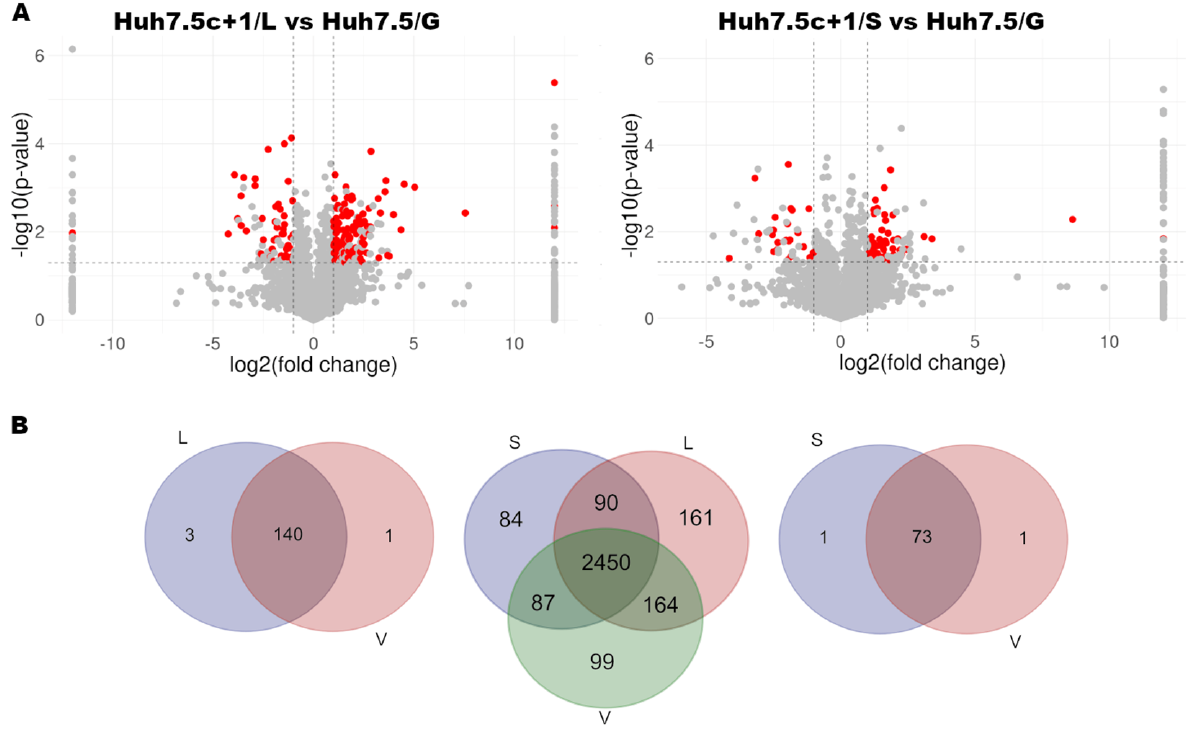
Figure 1 . ( A ) Volcano plots of the normalized L (left) and S (right) data sets. ( B ) Venn diagrams showing the overlap of all samples (center), of L versus control V filtered mass spec data (left), the overlap of S versus control V filtered mass spec data (right).